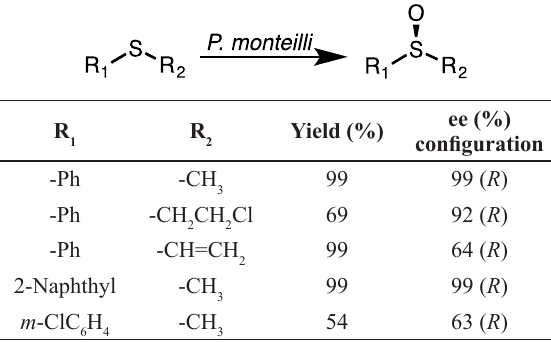
Oxidation of alkyl-aryl sulfides by Pseudomonas monteilii.